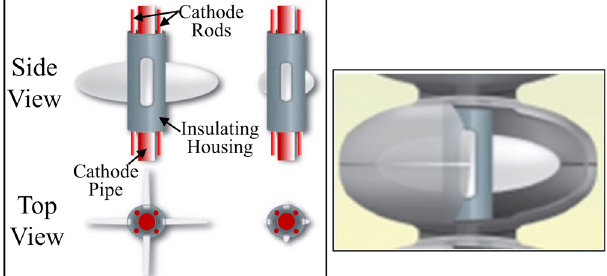
FIG. 1. Schematic of the Ninja cathode with insulating blades, cathode housing, Al cathode axial pipe, and four Al rods in the insulating housing to enhance the cathode surface area. The schematic on the right shows the cathode inside a cavity